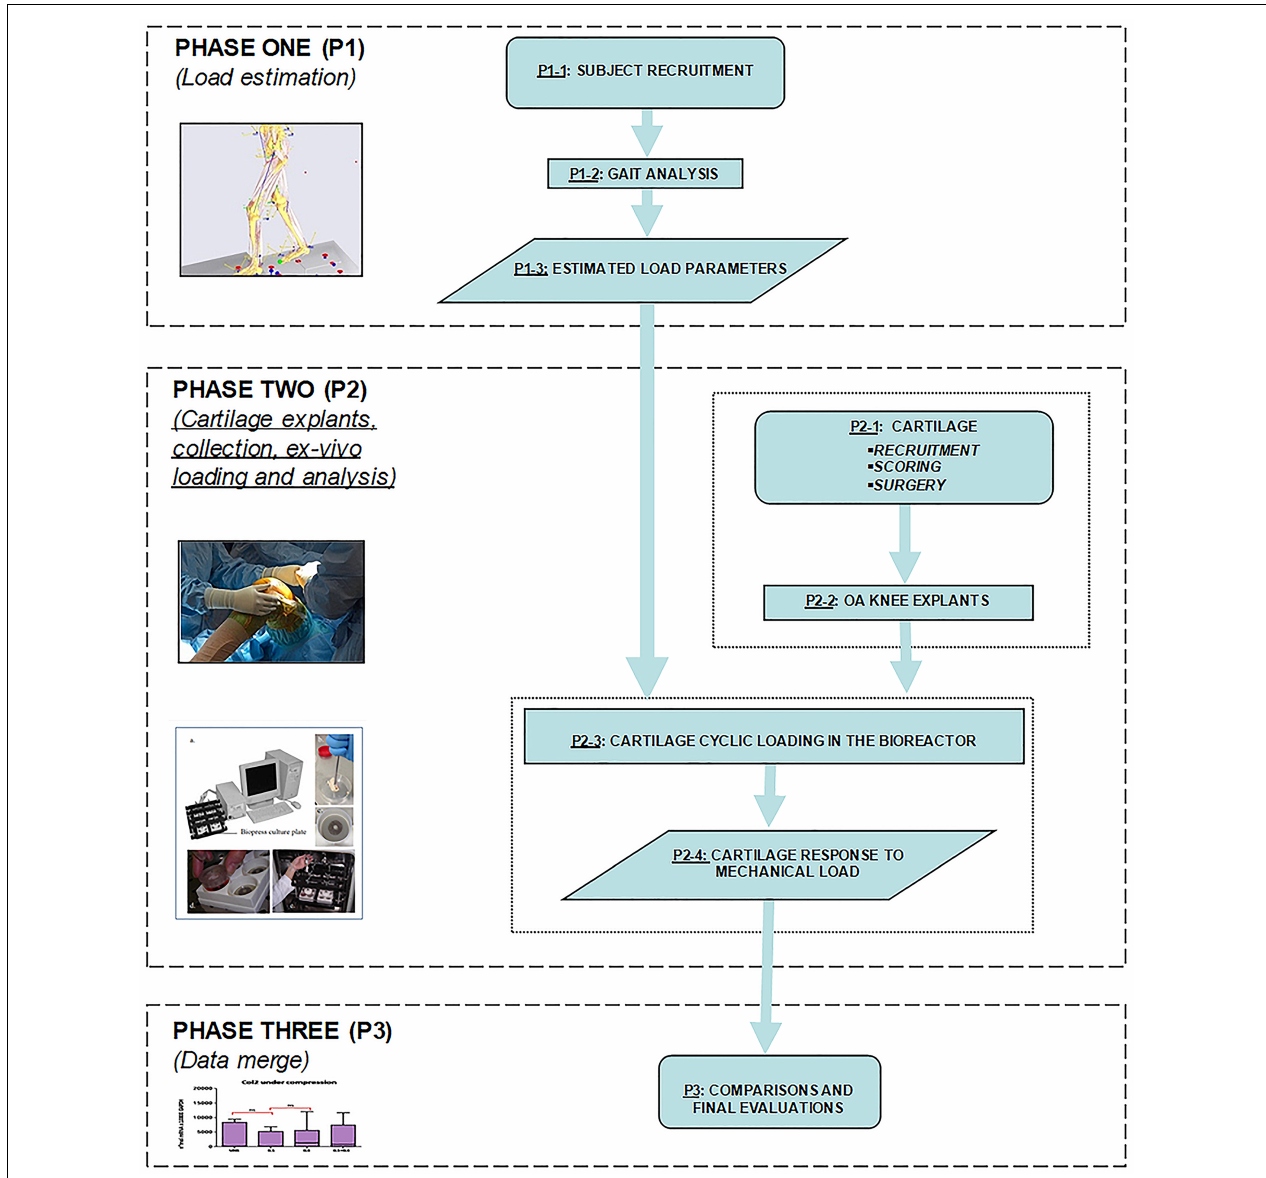
FIGURE 1 | Proposed Investigation Workflow reporting the sequence of all